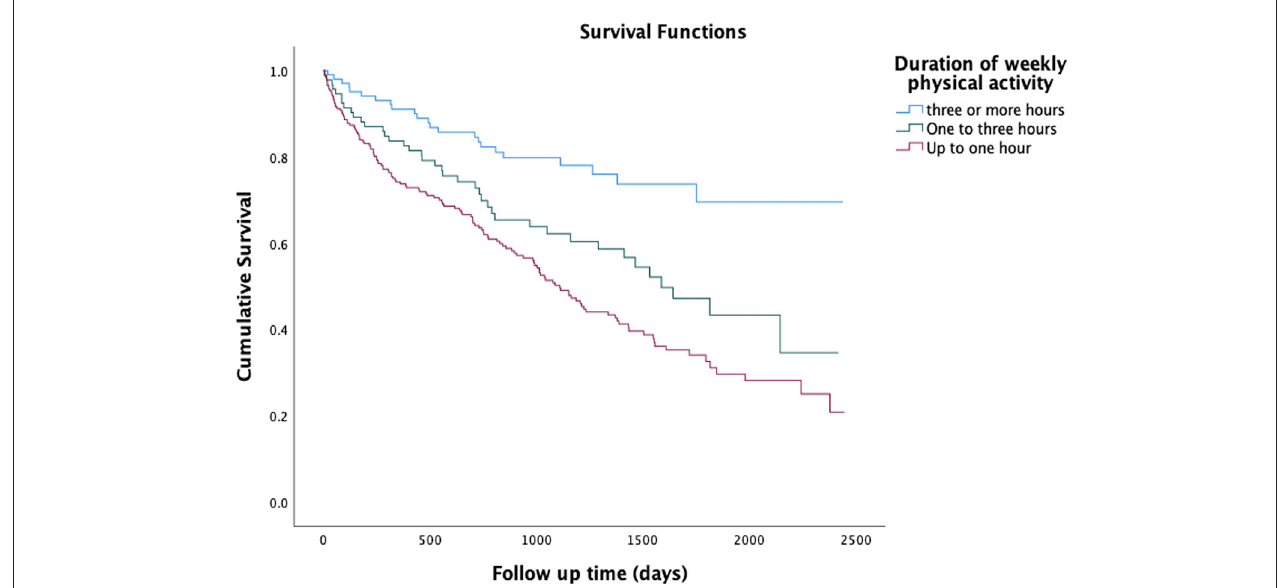
FIGURE 1 | Kaplan-Meier curves for the risk of death amongst 434 participants in HARVEST stratified according to duration of weekly physical activity in the past 12 months prior hospitalization for HF.